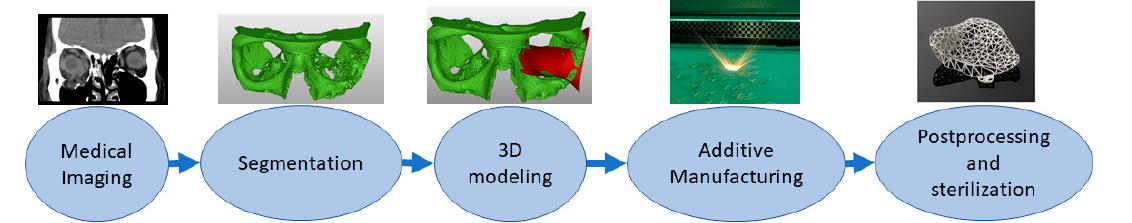
Figure 3. Typical process flow for implants.